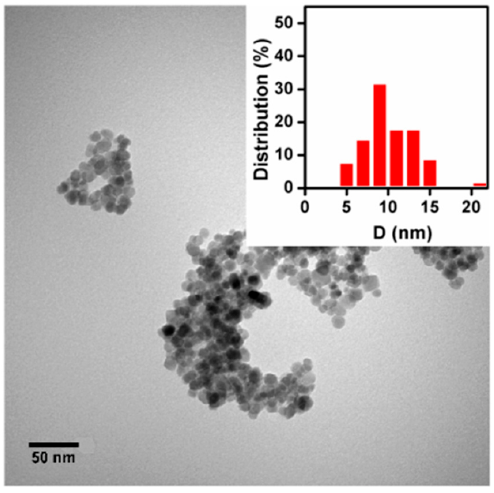
Figure 4. TEM image of Bare MIONs with histogram (inset).